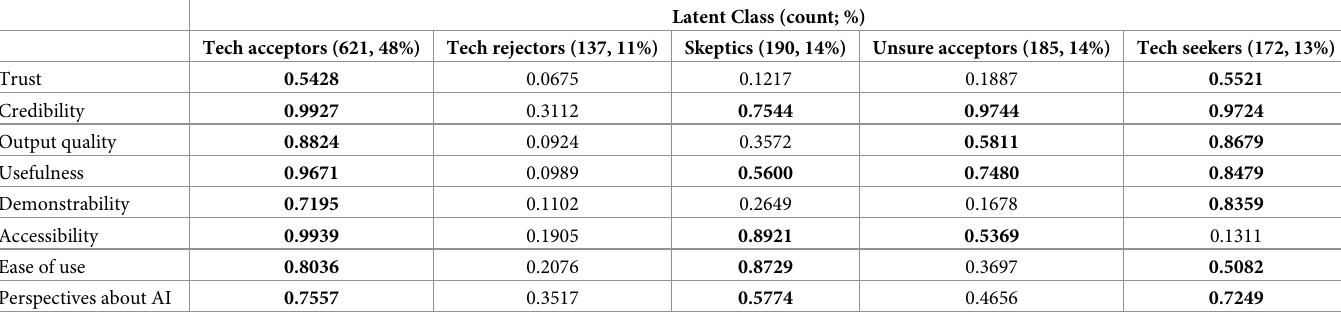
Table 4. Five-latent-class model: Probability of positive perceptions for each